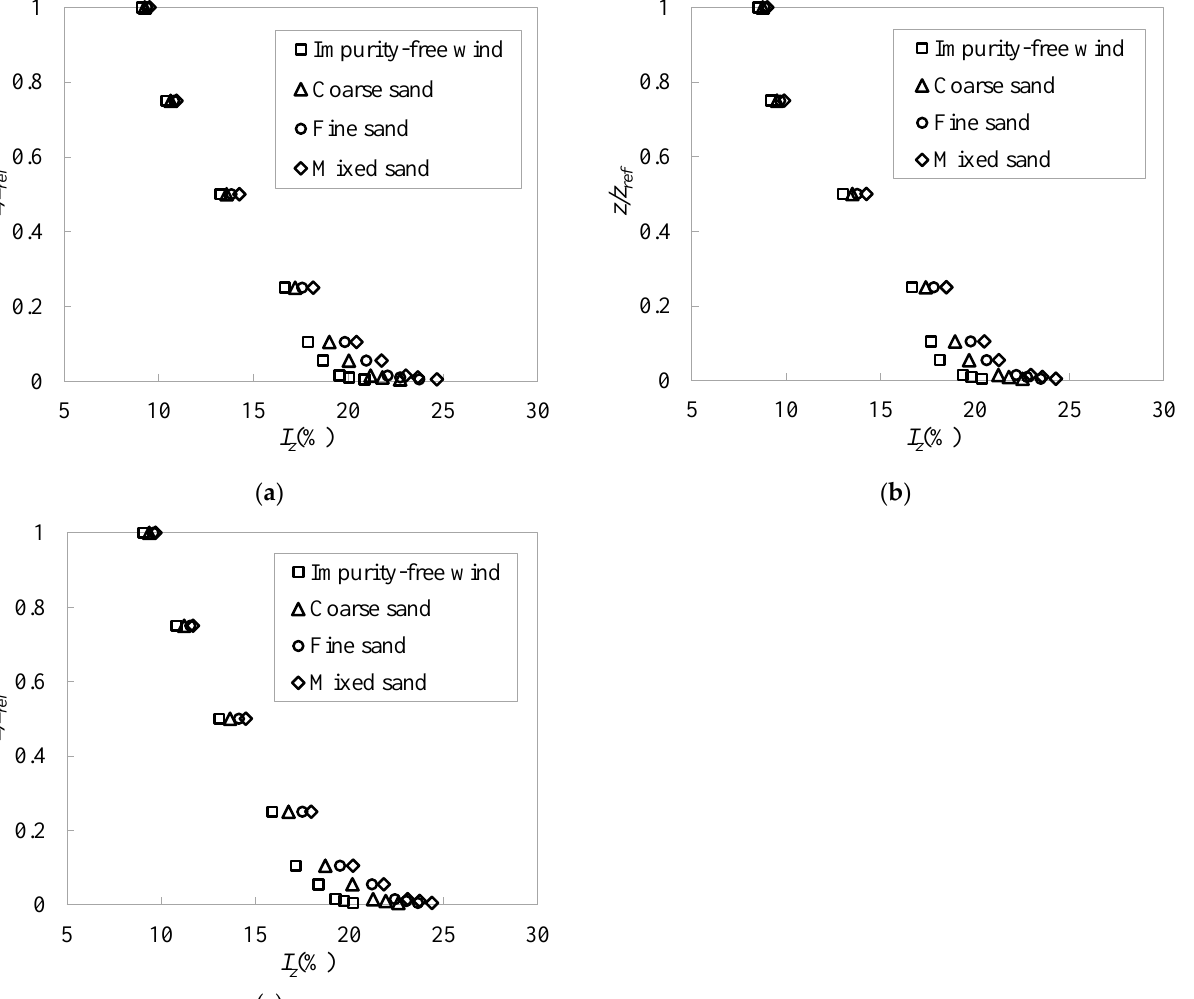
Figure 12. The turbulence intensity: ( a ) At the indicated wind speed of 14.74 m/s; ( b ) At the indicated wind speed of 16.68 m/s; ( c ) At the indicated wind speed of 18.61 m/s.